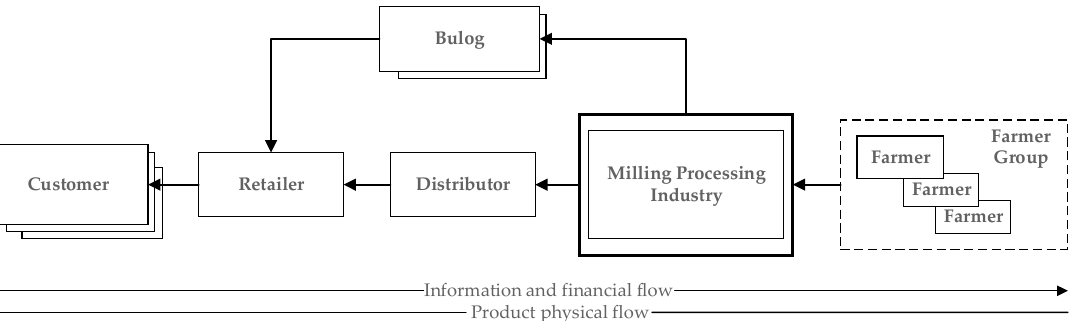
Figure 2. Rice supply chain model in Indonesia. Modifications from Purwandoko et al. [24] .